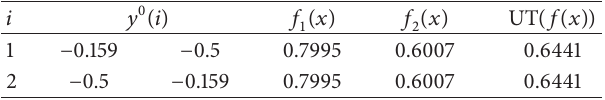
Table13:Theefficientpointsobtainedatthefirstiterationaccording to the perturbed reference points.